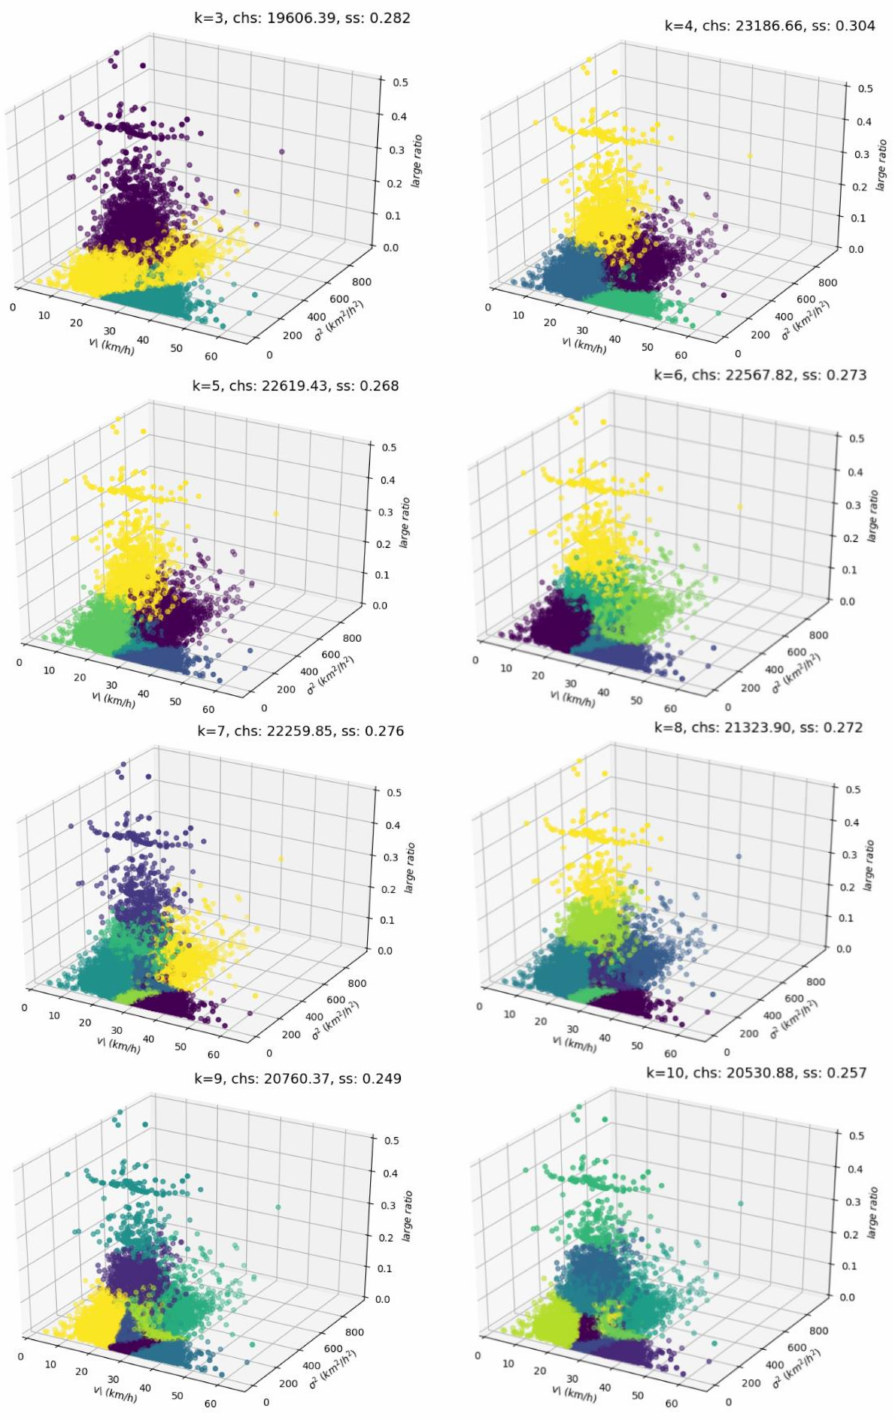
Figure 3. Clustering results of the tra ffi c state under the di ff erent